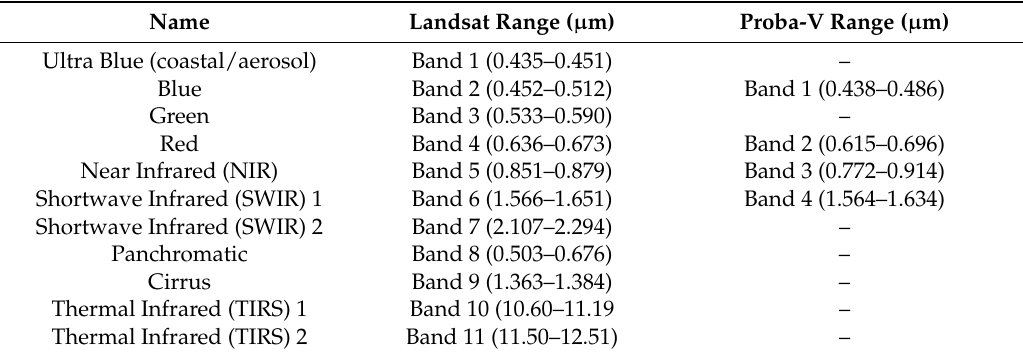
Table 1. Spectral range of Landsat and Proba-V bands.